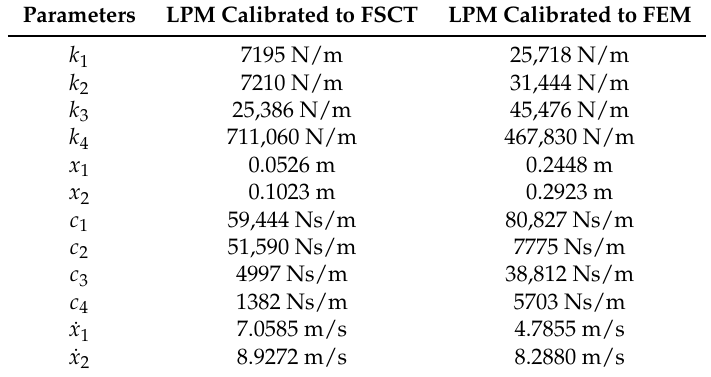
Table 1. Estimated structural parameters of the vehicle frontal crash model calibrated at 56 km/h.